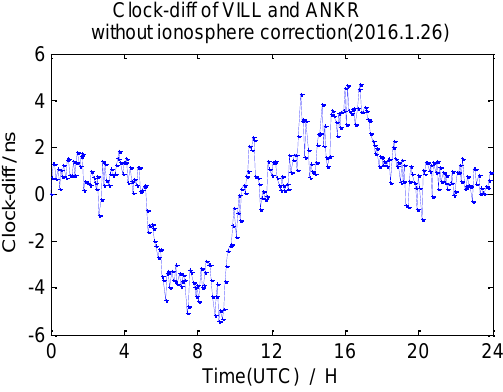
Figure 12. Clock difference between VILL and ANKR (without ionosphere correction).